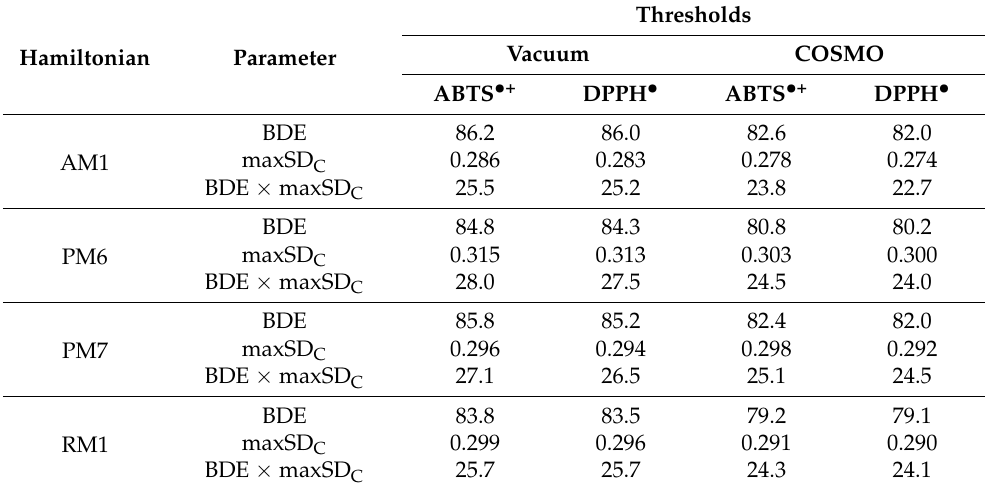
Table 1. Thresholds for distinguishing between active and inactive hydroxyl groups for BDE, maxSD C , and BDE × maxSD C classification parameters obtained in different semi-empirical simulations